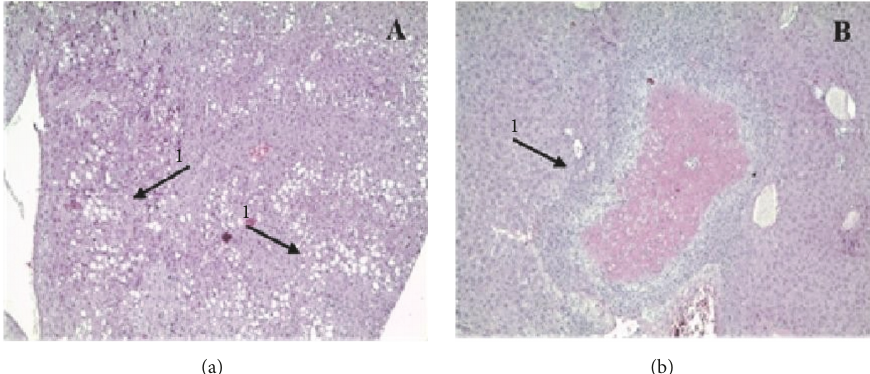
Figure 2: Liver tissue with presence of moderate steatosis (1) in the animal subject to a dose of 1000mg/kg of K. brasiliensis extract in the subchronic evaluation (10x) (A). Ischemic renal tissue with coagulative necrosis (1) in the animal submitted to a dose of 1000mg/kg of K. brasiliensis extract in the subchronic evaluation (10x) (B).